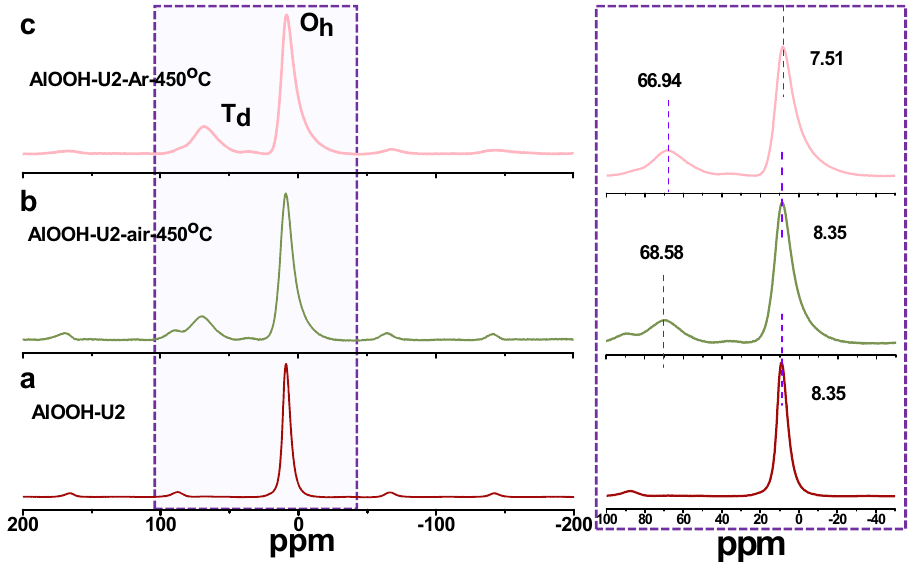
Fig. 5 27 Al solid NMR of AlOOH. Catalyst treated in different conditions. a AlOOH-U2. b AlOOH-U2-air-450 °C. c AlOOH-U2-Ar-450